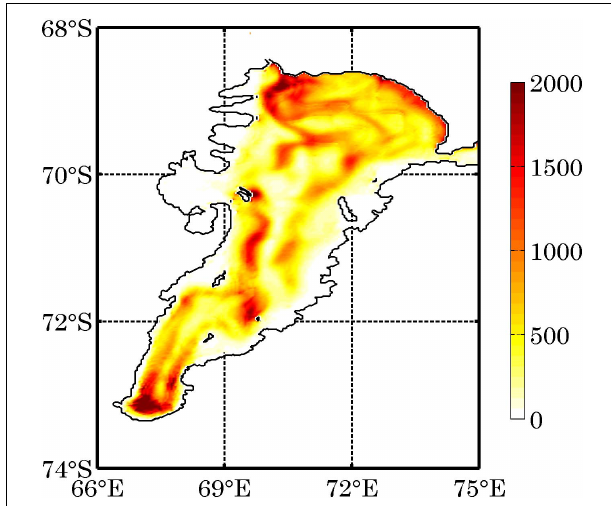
FIGURE 3 | The annual mean distributions of the vertically integrated EKE _ annual (J m − 2 ). Note that the time-mean used here is the 5-year mean which is different from monthly mean used in Figure 2B .